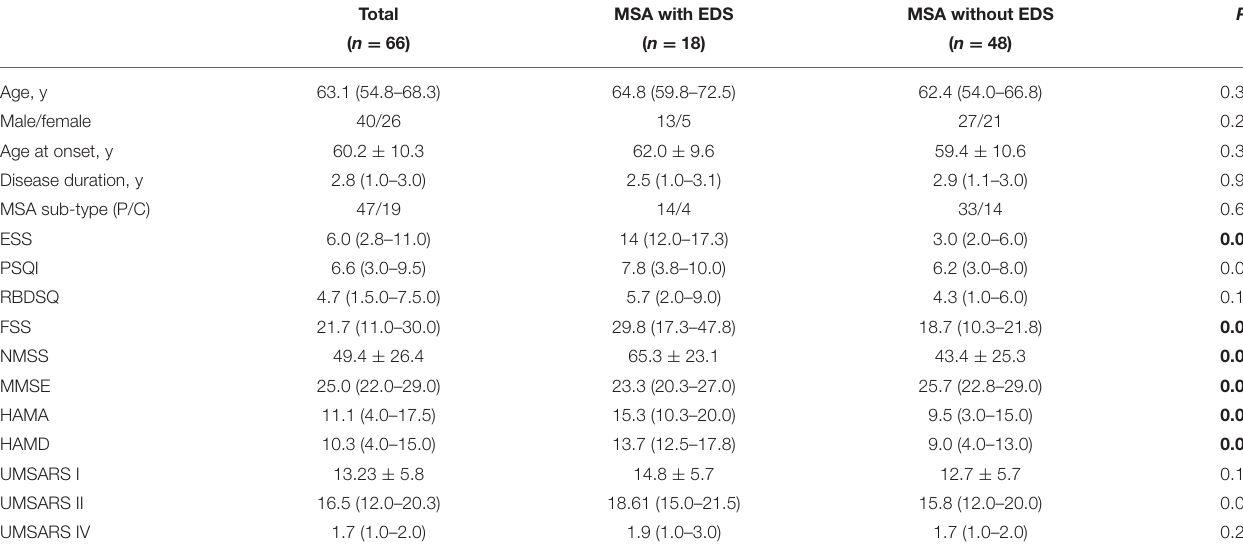
TABLE 1 | Demographic and clinical characteristics of multiple system atrophy (MSA) patients with and without excessive daytime sleepiness (EDS).